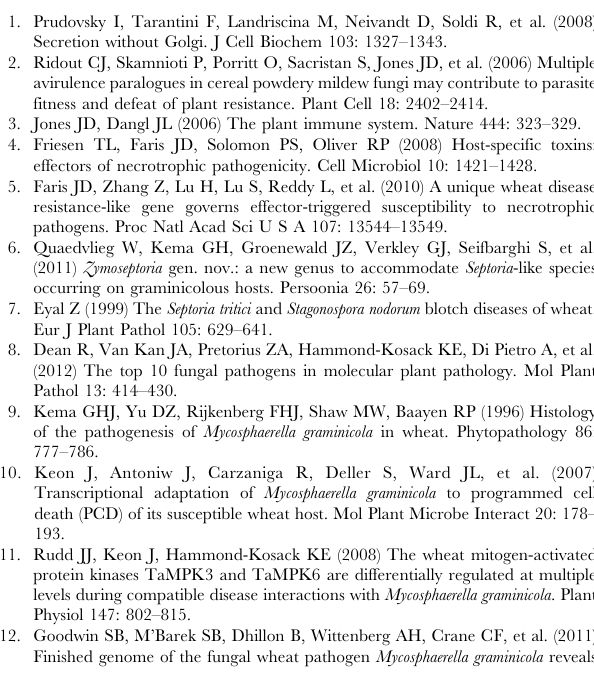
Table S1 The list of species used for the various comparative analyses. Table S2 Experimentally verified s ecreted